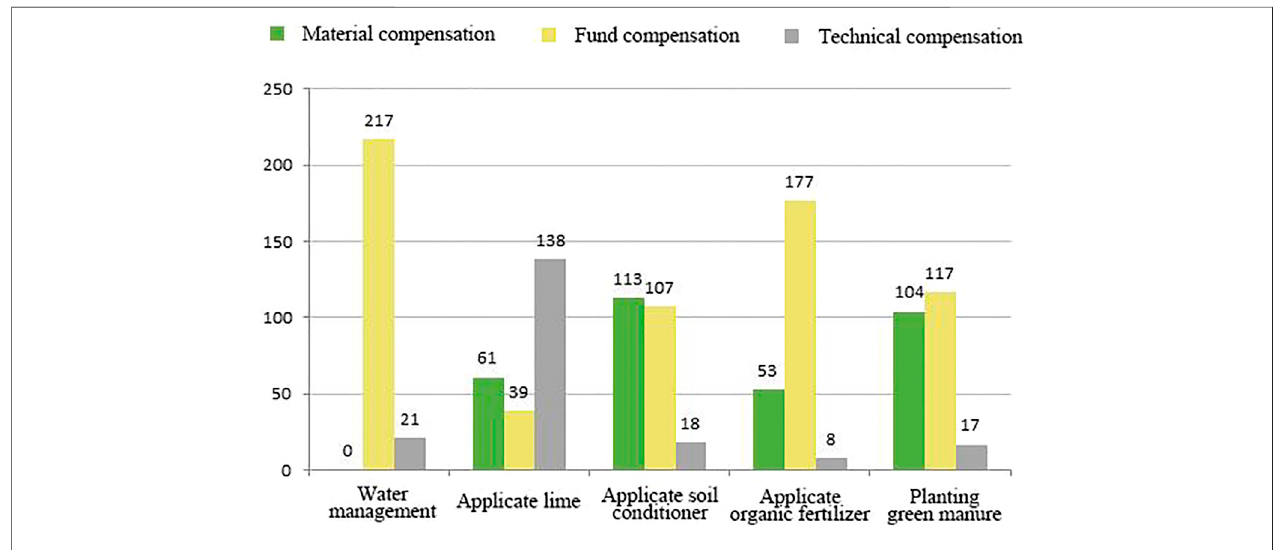
FIGURE 4 | Compensation mode